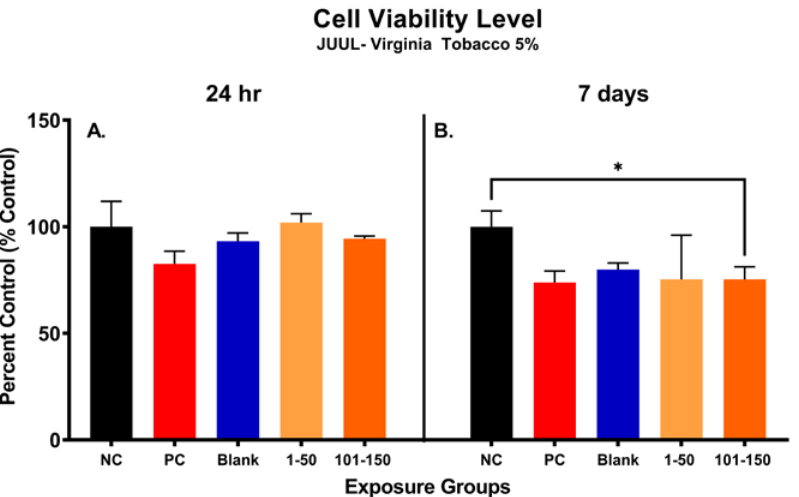
Figure 4. Metabolic capacity of pod-type ENDS aerosol exposed SAEC determined by MTS assay. After 24 h, the metabolic activity of SAEC exposed to JUUL Virginia Tobacco 5% aerosols was not significantly reduced at either of the puff fractions (1–50) and (101–150) ( A ). However, repeated exposure of 7 days elicited a significant reduction (*, p < 0.05) in cellular viability of 25% at 101–150 puffs as compared to the negative control ( B ).